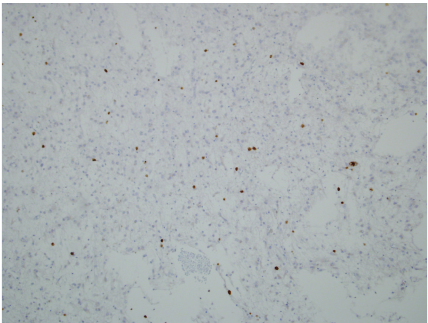
Figure 6: Ki 67 proliferative index of 10% per 10 HPF in the anaplastic astrocytoma.